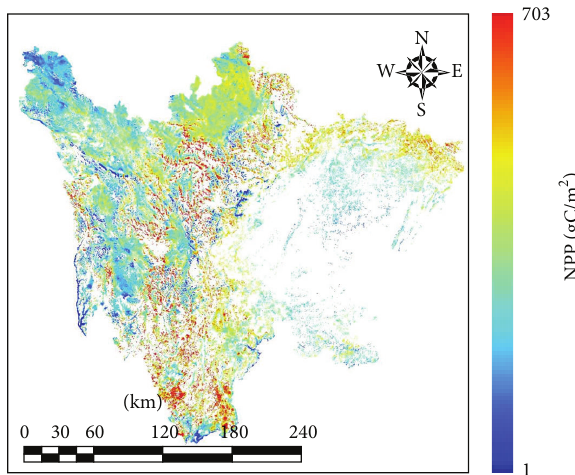
Figure 8: Distribution of NPP for Sichuan grassland in 2011.